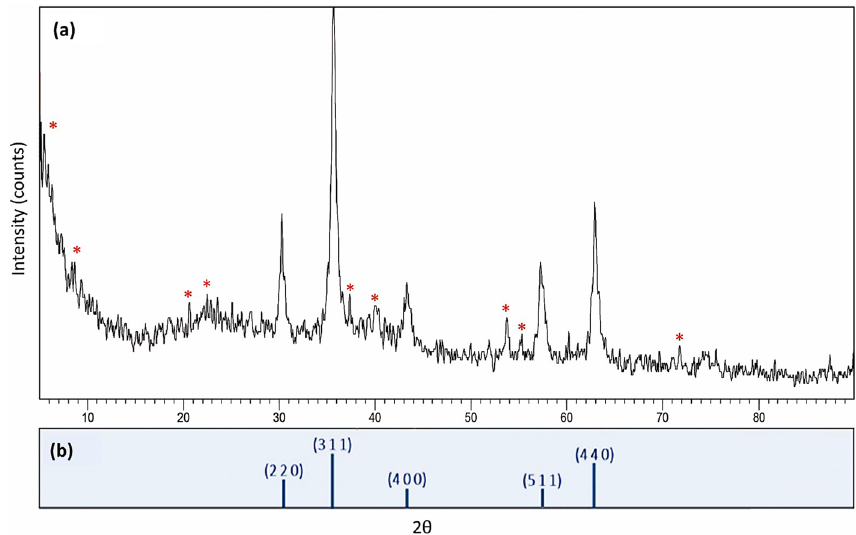
Figure 6. The XRD pattern of the fabricated Fe 3 O 4 @SiO 2 /TABHA NPs ( a ), and Fe 3 O 4 MNPs ( b ).